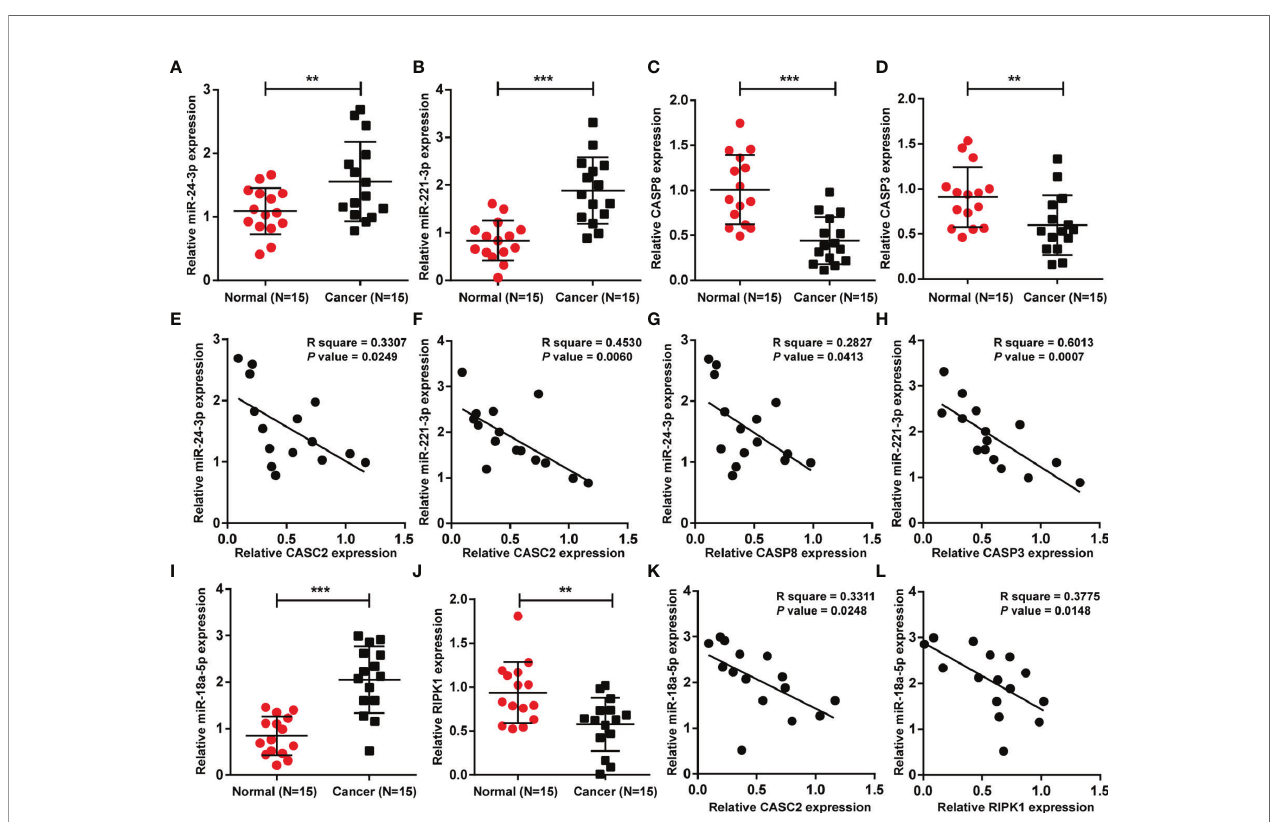
FIGURE 9 | Expression and correlation of aforementioned factors in tissue samples. (A – D) The expression of miR-24-3p, miR-221-3p, caspase-8, and caspase-3 was determined in HCC tissues and non-cancerous tissues using qRT-PCR. (E – H) The correlations between CASC2, miR-24-3p, miR-221-3p, caspase-8, and caspase-3 were analyzed using Pearson ’ s correlation analyses. (I, J) miR-18a and RIPK1 expression was determined in HCC tissues and non-cancerous tissues using qRT-PCR. (K, L) The correlations between CASC2, miR-18a, and RIPK1 were analyzed using Pearson ’ s correlation analyses. **p < 0.01, ***p < 0.005, compared with normal